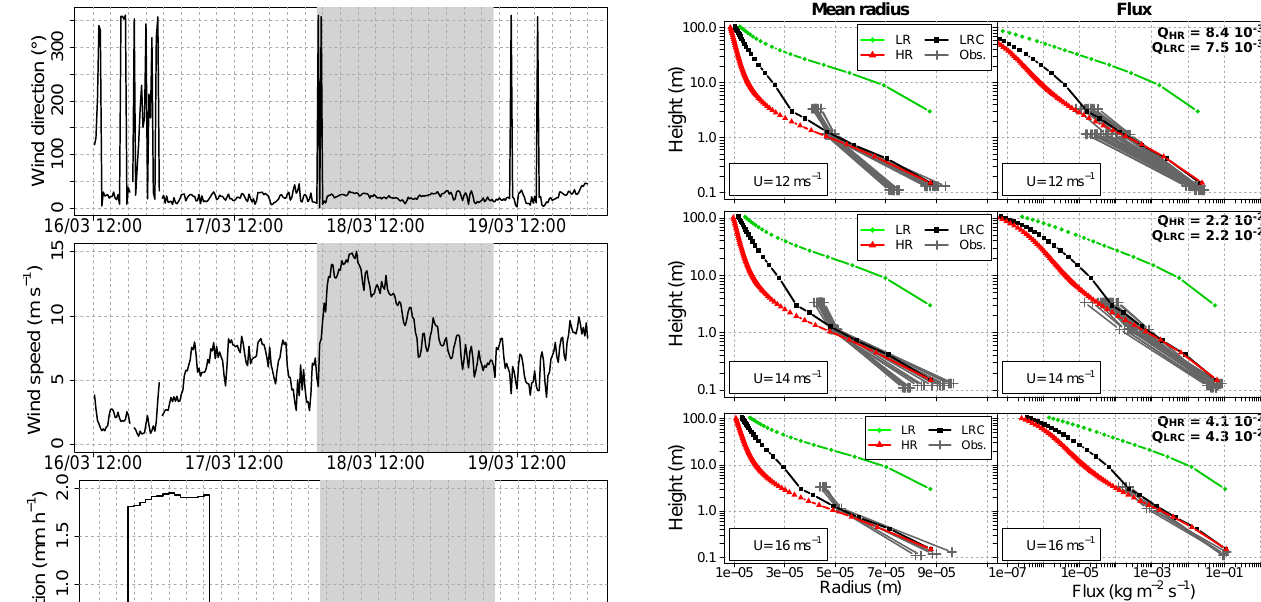
Fig. 5. Vertical profile of mean radius (Left) and fluxes (Right) of blown snow particles measured by SPC and simulated by Meso- NH/Crocus 1-D for 3 categories of 5m wind speed and 3 model configurations: LR (Low Resolution), HR (High Resolution) and LRC (Low Resolution Canopy) (see Sect. 5.1 for more details). Q HR and Q LRC (in bold) designate the vertically integrated trans- port rate of suspended snow over the lowest 100m of the atmo- sphere (in kgm − 1 s − 1